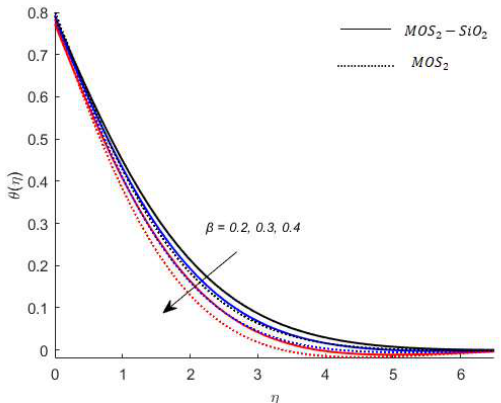
Figure 9. Variation in temperature for Ec when M = 0.2, Pr = 2.36, Sr = 0.1, Sc = 0.8, ( Gr ) = 0.1, K = 0.1, Bi = 0.05, and β ∗ = 0.1.